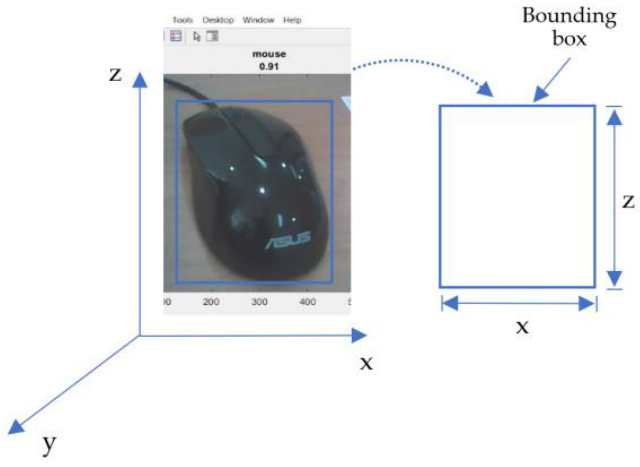
Figure 8. Convert the bounding box to x , y , and z coordinates.